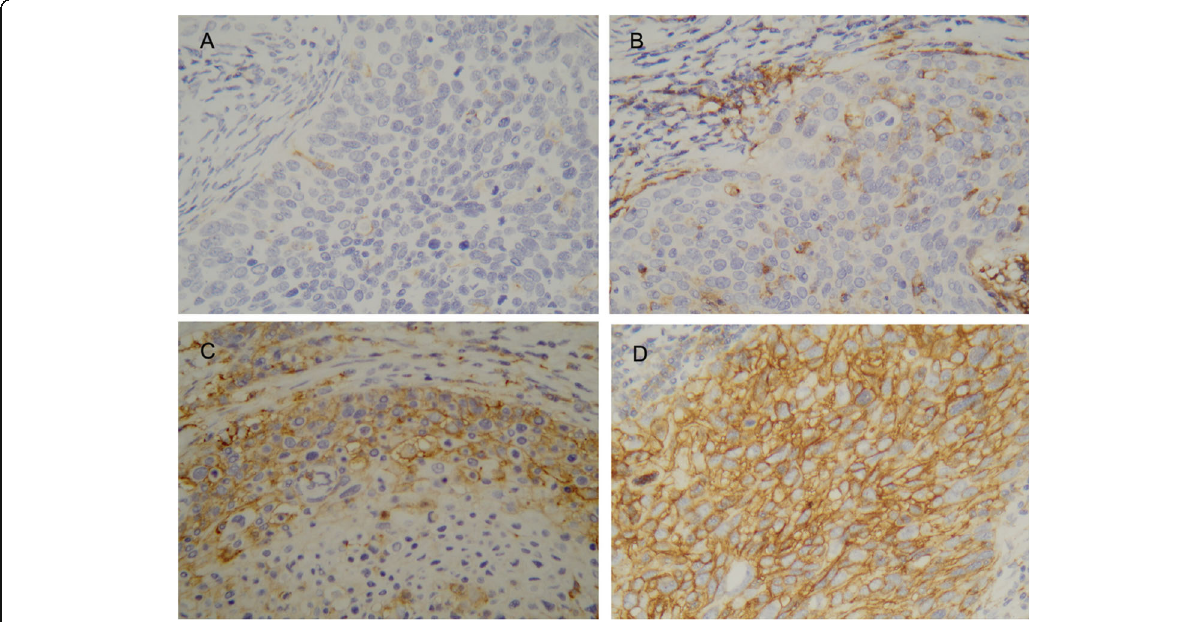
Fig. 1 Immunohistochemical staining patterns for PD-L1 on tumor cell. Representative negative expression (A), patchy expression (B), marginal(C), and diffuse expression(D) for